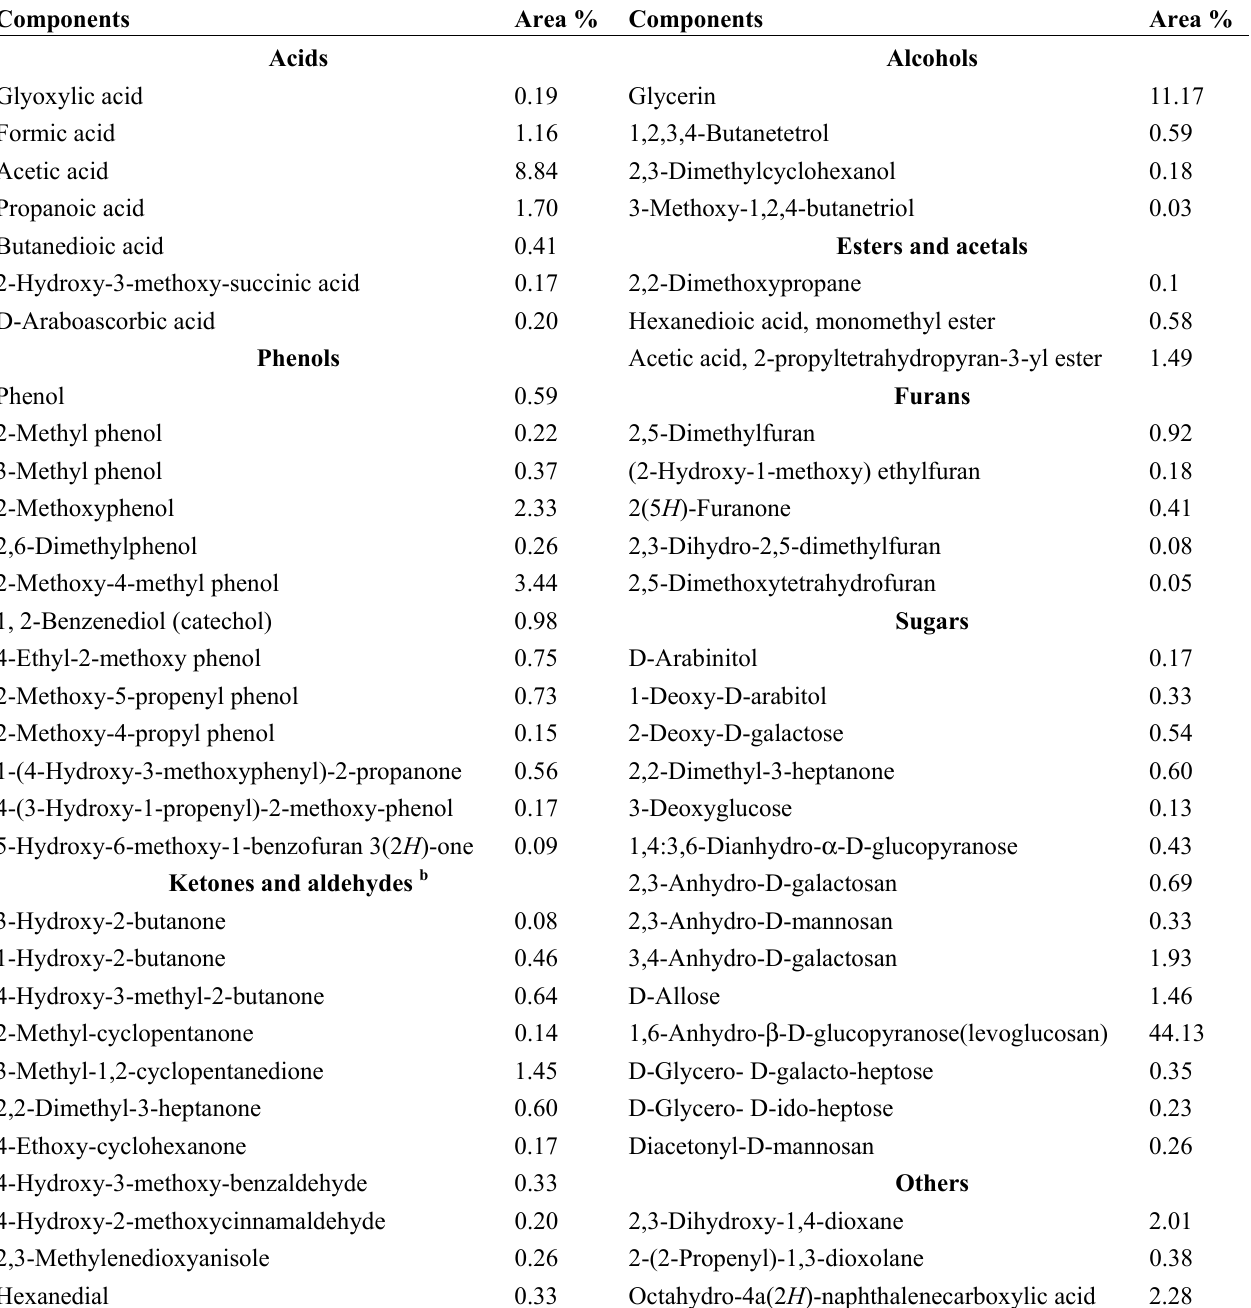
Table A1. Selected organic oxygen-containing components of raw bio-oil a